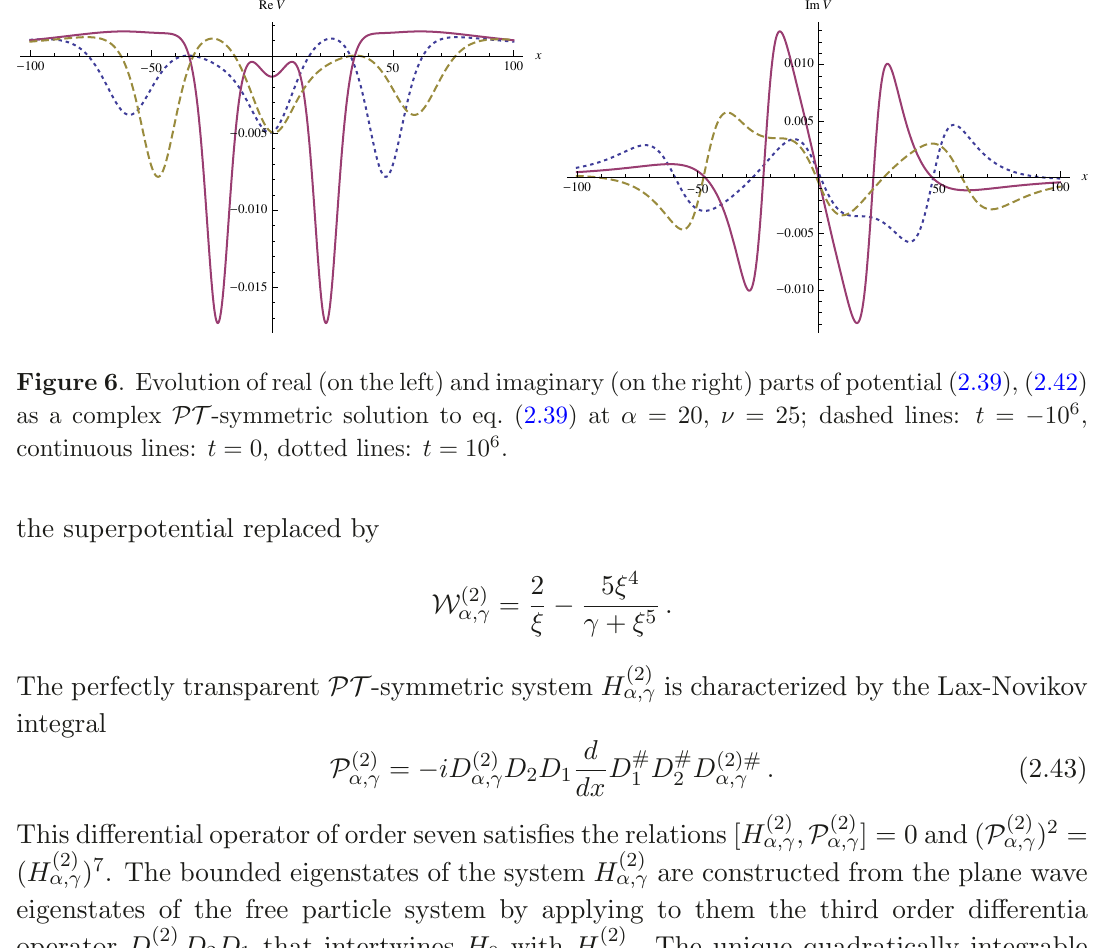
Figure 5 . Real and imaginary parts of potential (2.39), (2.41) as a complex tionary ( t = 0) solution to eq. (2.31) at α = 300 and ν = 0 (on the left) and ν = 1 . 5 (on the right).